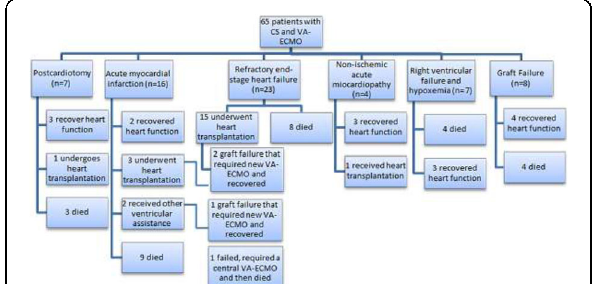
Fig. 1 (abstract 0331). Different cardiogenic shock etiologies